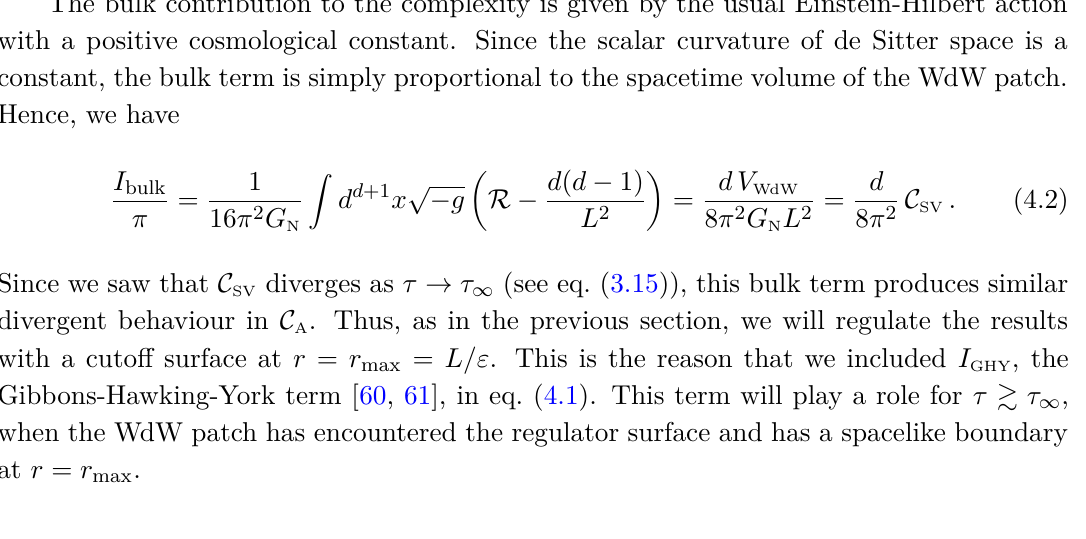
( τ ) . The SV ( τ ≤ τ ∞ ) . After SV ( τ ≥ τ ∗ ) grows linearly as shown by the SV , ε = 1 10 10